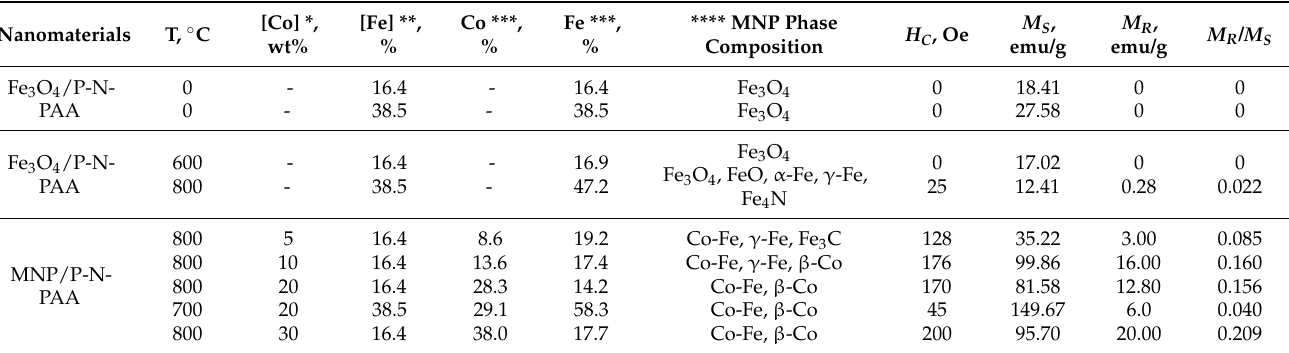
Table 3. Magnetic properties of nanomaterials.